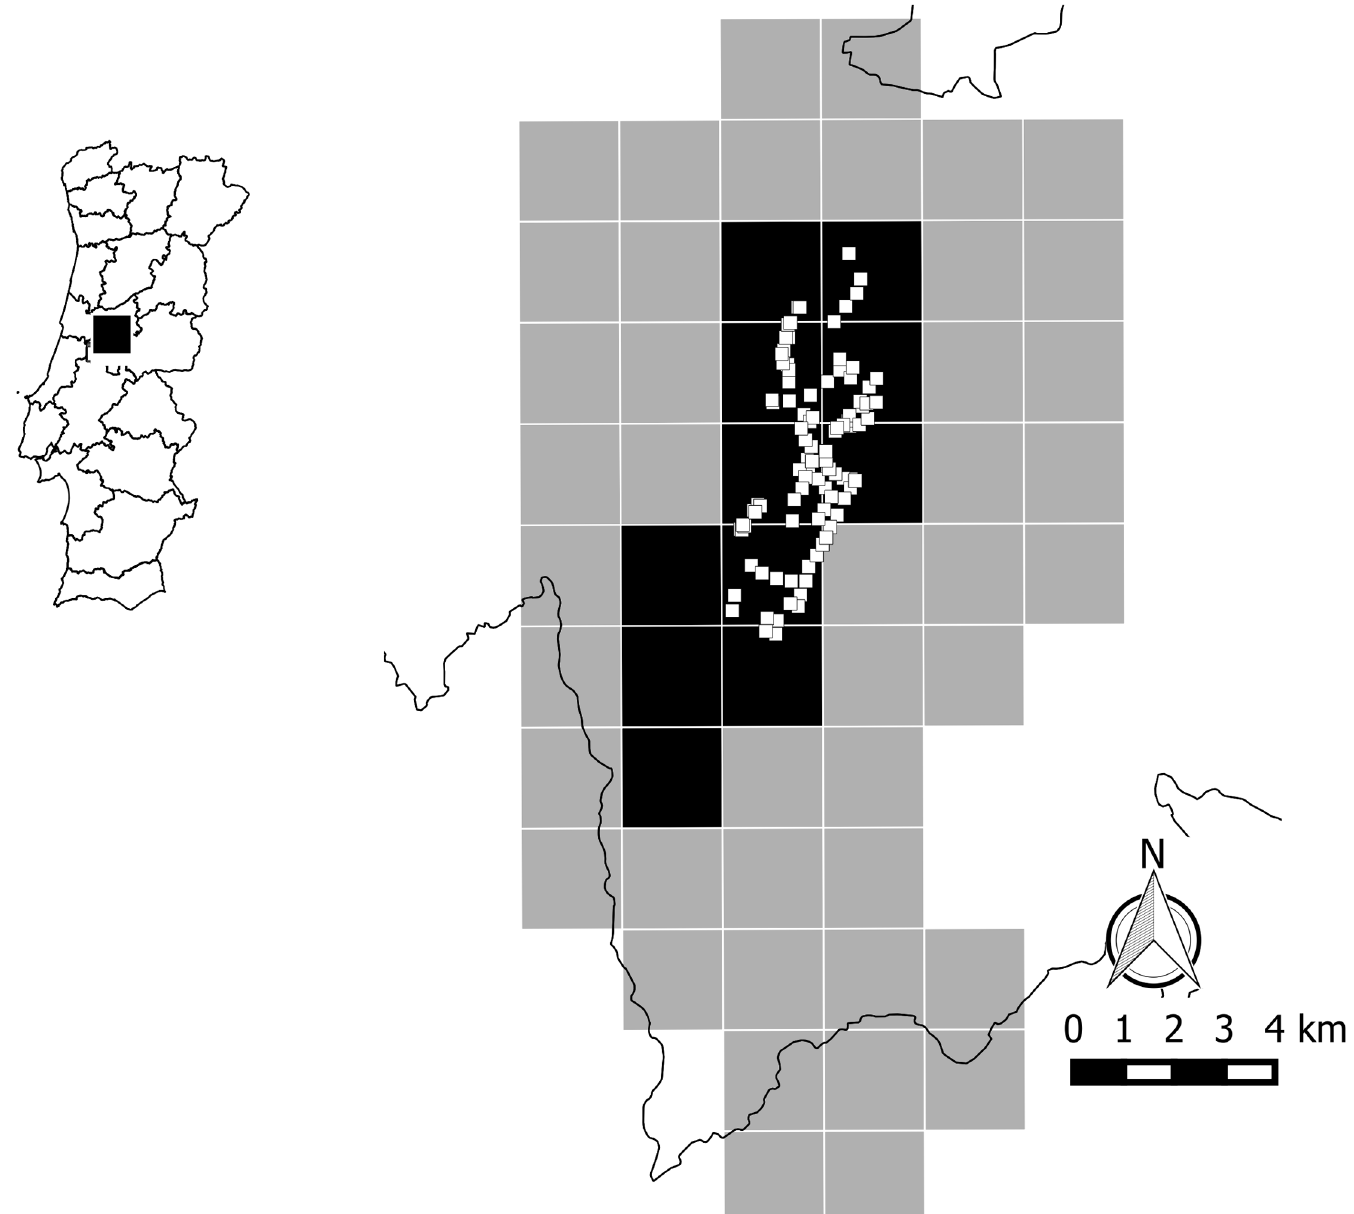
Fig 1. Study Area. Map of Portugal and study region (left), and detailed information (right) on 2 x 2 km tetrads used to sample the land snail Candidula coudensis . Black grid squares indicate presence, grey squares indicate absence of either live individuals or shells. Within black squares, small white squares correspond to locations of 5 x 5 m quadrats used to assess population density. The type-locality where the species was described is located at near the center of the